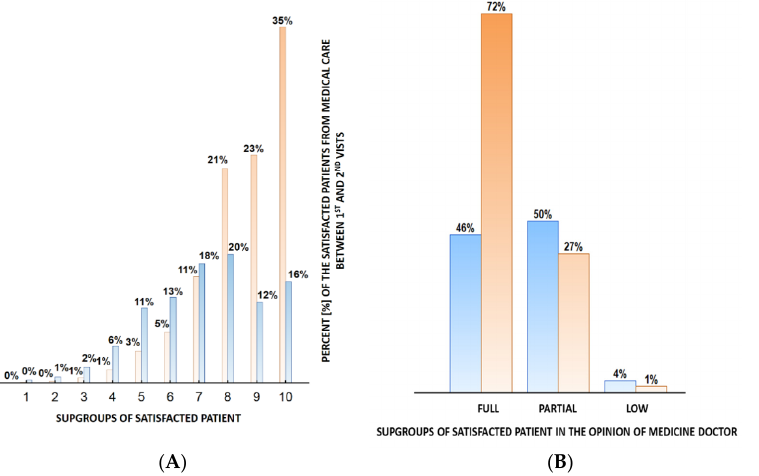
Figure 9. The comparison of the satisfaction level of the patients from the medical care between first and second visit. Blue graph—first visit; orange graph—second visit. Graph ( A ) represents the percent of the satisfied patients calculated for each subpopulation separately. The subpopulations of the patients were created according to the subjective opinion of the patients: 1—the lowest satisfaction up to 10—the highest satisfaction. Graph ( B ) represents the percent of satisficed patients according to the opinion of the medicine doctor. The percent of the satisfied patients were calculated separately for each of the following subgroups: full, partial and low.